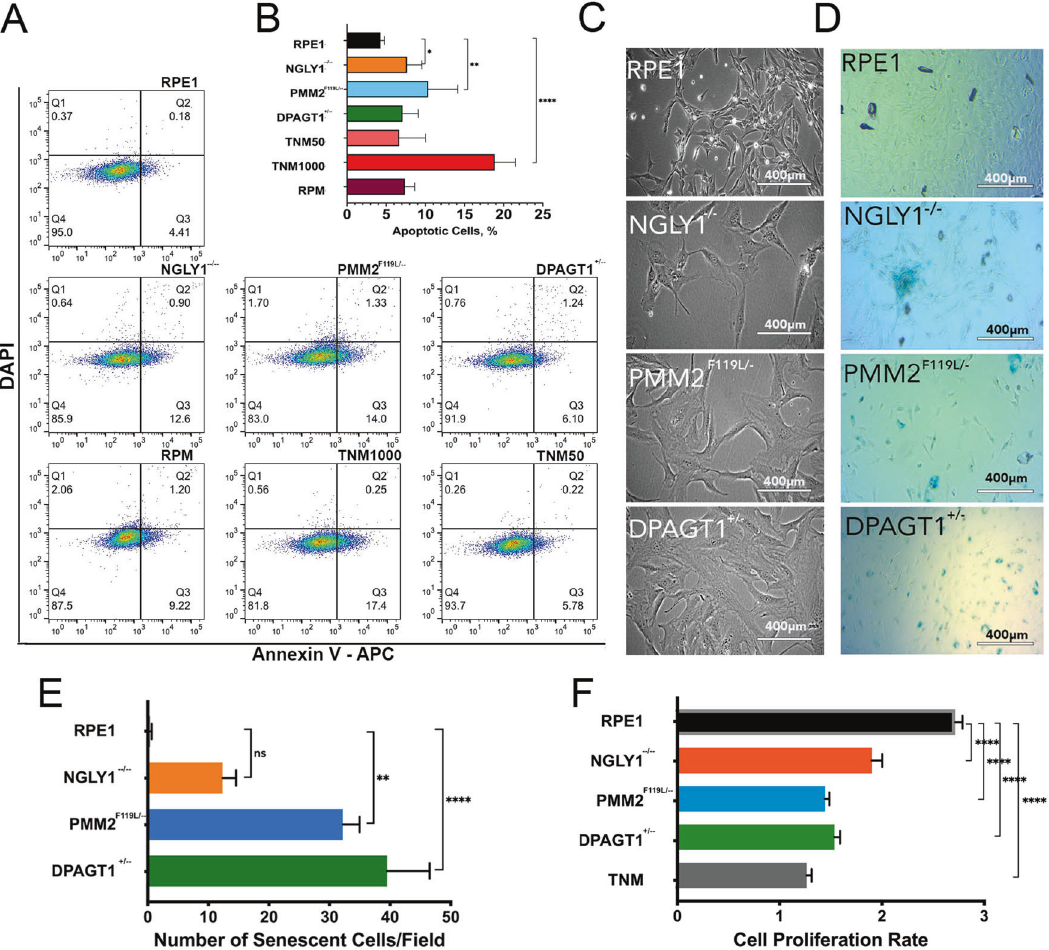
Fig. 3 CDG and CDDG cellular models exhibit low levels of apoptosis, line-dependent levels of senescence and reduced proliferation. A Representative dot-blots of apoptosis detection (Annexin V staining) in RPE-1, CDG and CDDG lines. Tunicamycin was used as a